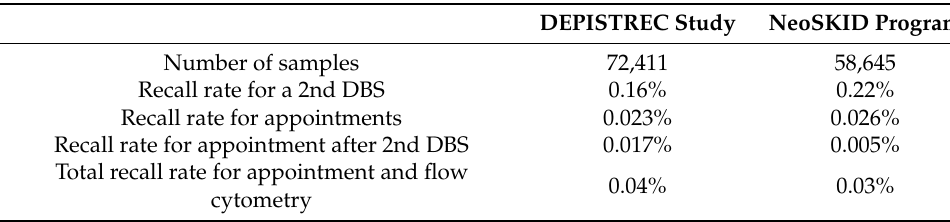
Table 1. Recall rates for SCID screening.